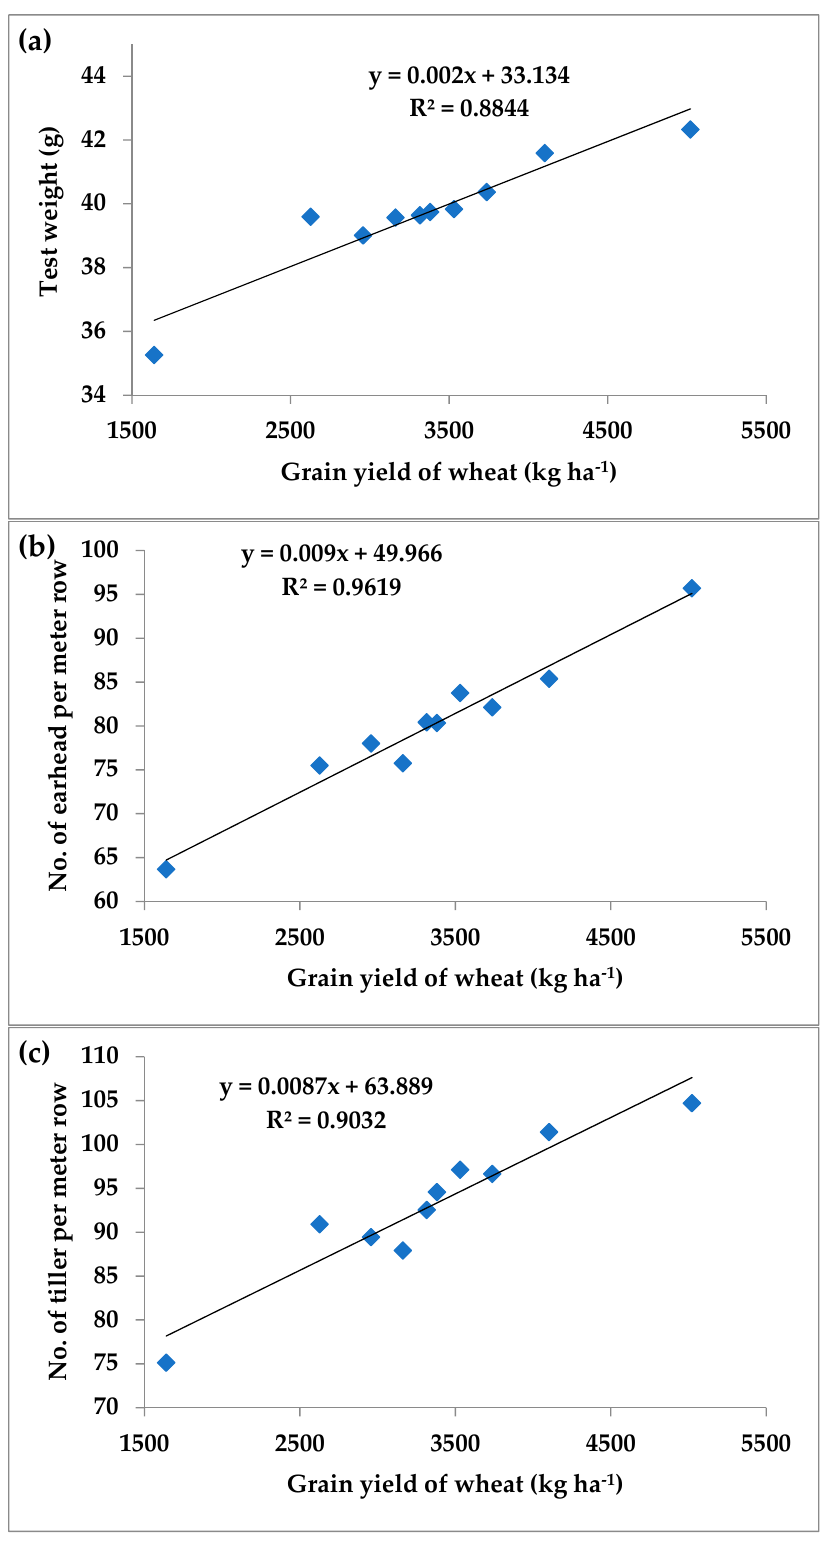
the combination of 75% NPK + 10 t ha − 1 FYM and bio-inoculants (PGPR + VAM) applica- tion as compared with balanced fertilization (100% NPK) and the rest of the treatment combinations in the two-year wheat field experiment.